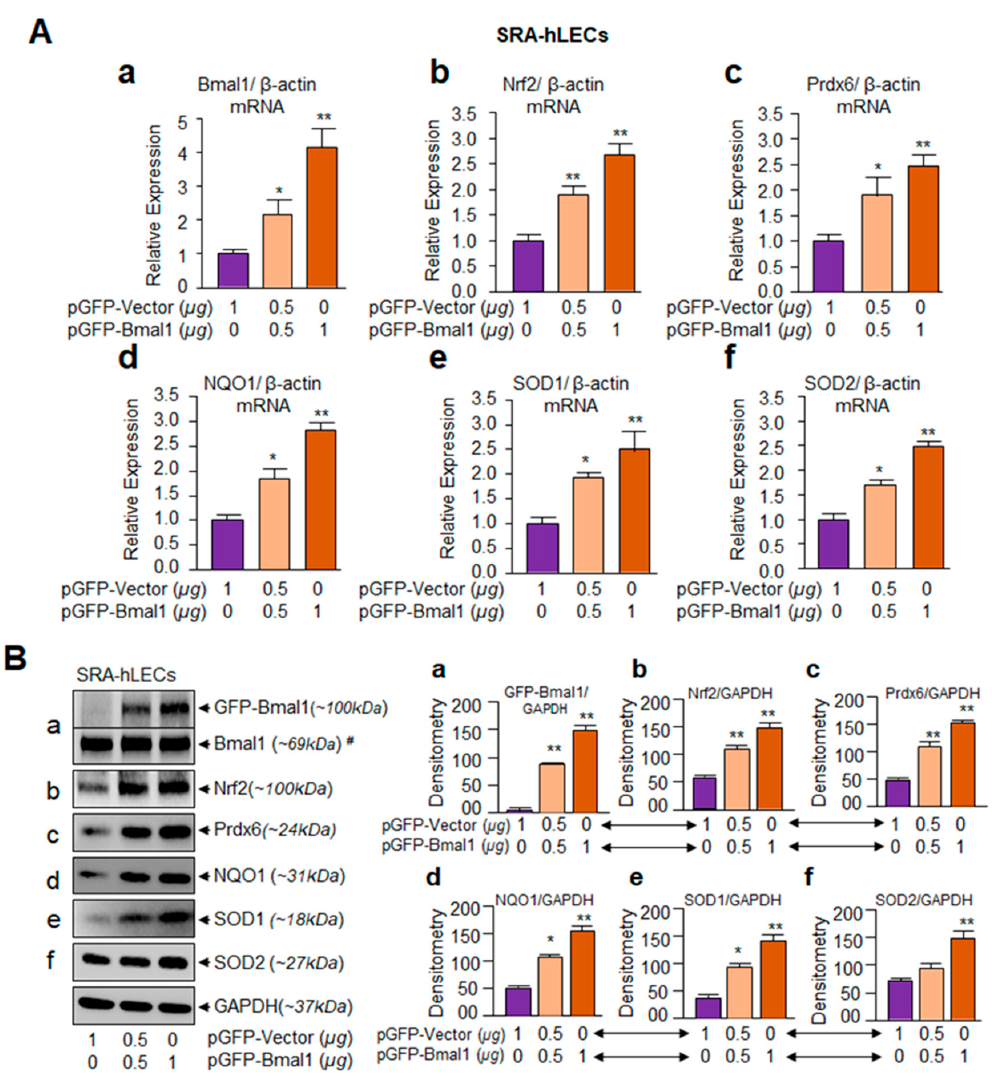
Figure 2. SRA ‐ hLECs overexpressing Bmal1 showed augmented expression of Nrf2 and Nrf2/ antioxidant response element (ARE)–dependent antioxidants . SRA ‐ hLECs transfected with pGFP ‐ Vector or pGFP ‐ Bmal1 plasmid. Total RNA and protein were isolated from transfectants and qPCR and protein analysis were conducted as described in the Materials and Method’ section. Bmal1 (a) overexpression significantly increased Nrf2 (b), Prdx6 (c), NQO1 (d), SOD1 (e), and SOD2 (f) mRNA ( A ) and protein ( B ) expression. Protein blots were quantified using densitometer, and levels were normalized to corresponding GAPDH levels. Histograms are shown in right side of Western blot. Data represent means ± S.D. of three independent experiments. Violet vs light orange and dark orange bars; * p < 0.05, ** p < 0.001. #; Endogenous Bmal1. 3.3. Bmal1 ‐ Deficient SRA ‐ hLECs Showed Down ‐ Regulation of Nrf2/ARE Pathway as Observed in Aging Cells Results from aging hLECs showed (1) a progressive reduction of Bmal1 expression, along with Nrf2 ‐ mediated antioxidant pathway (Figure 1), and (2) Bmal1 overexpression ‐ mediated increased